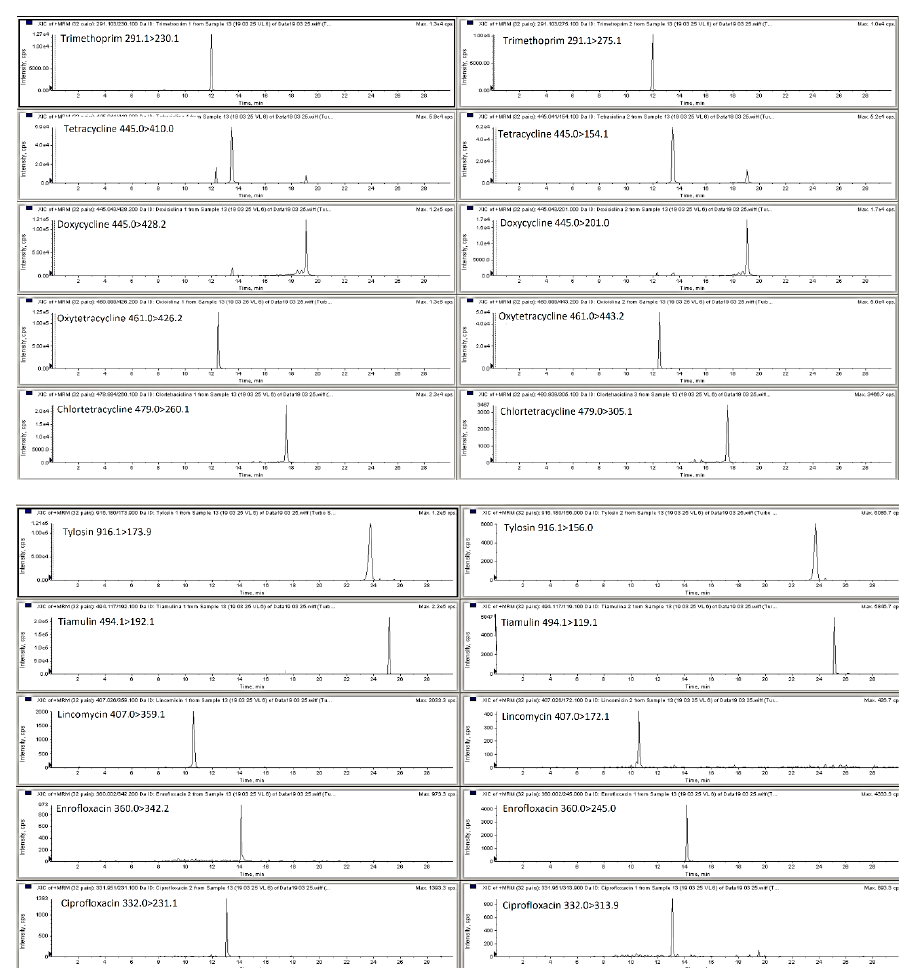
Figure 2. LC ‑ MS/MS MRM chromatograms of spiked pig feces sample with all analyzed compounds Figure 2. LC-MS / MS MRM chromatograms of spiked pig feces sample with all analyzed at first validation level (trimethoprim—25 µg/kg; oxytetracycline, tetracycline, chlortetracycline, compounds at first validation level (trimethoprim—25 µ g / kg; oxytetracycline, tetracycline, doxycycline, tylosin, tiamulin—100 µg/kg; lincomycin—125 µg/kg; enrofloxacin, ciprofloxacin—50 chlortetracycline, doxycycline, tylosin, tiamulin—100 µ g / kg; lincomycin—125 µ g / kg; enrofloxacin, µg/kg). ciprofloxacin—50 µ g /